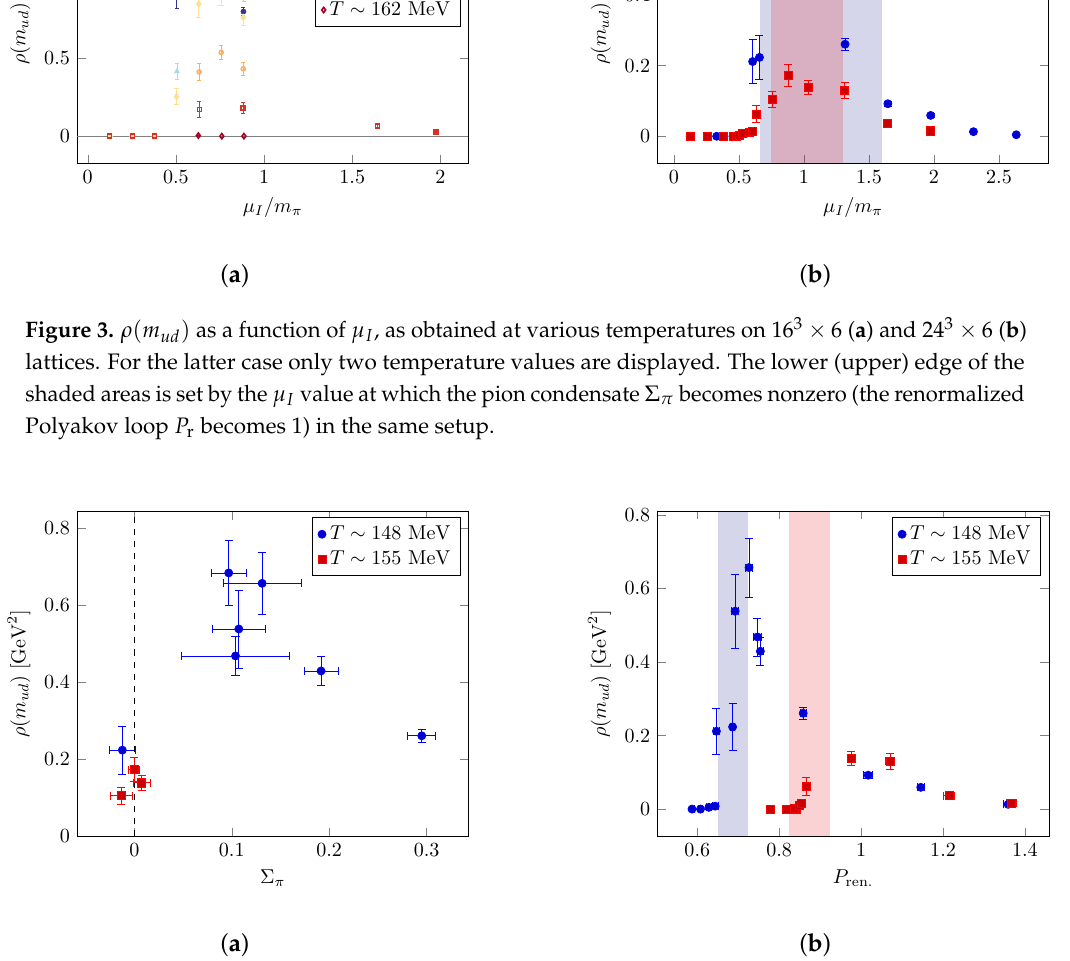
Figure 4. ρ ( m ud ) as a function of Σ π ( a ) and of P ren. ( b ). For the latter case the shaded areas correspond to the range of values P ren. takes within the green Bose-Einstein condensation (BEC) boundary in Figure 1b at the two considered